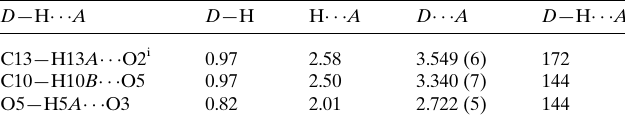
Table 1 Hydrogen-bond geometry (A˚ , (cid:4) ).